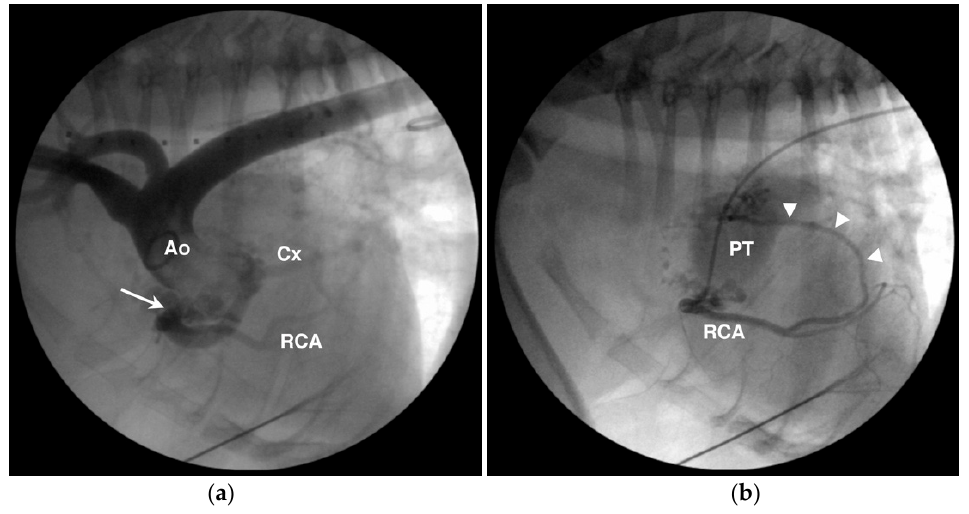
Figure 10. Angiographic images from an English bulldog with single right coronary ostium, aneurysmal dilation of the prepulmonary left coronary artery and circumflex branch (Cx), and coronary to pulmonary arterial fistulae/malformation. ( a ) The aortic root (Ao) injection shows the single right coronary ostium (arrow), aneurysmal dilation of the Cx, and a more normal diameter right coronary artery (RCA). ( b ) Selective right coronary angiogram from the same dog as in ( a ) showing one of several fistulous connections (arrowheads) from the RCA to the pulmonary trunk (PT).